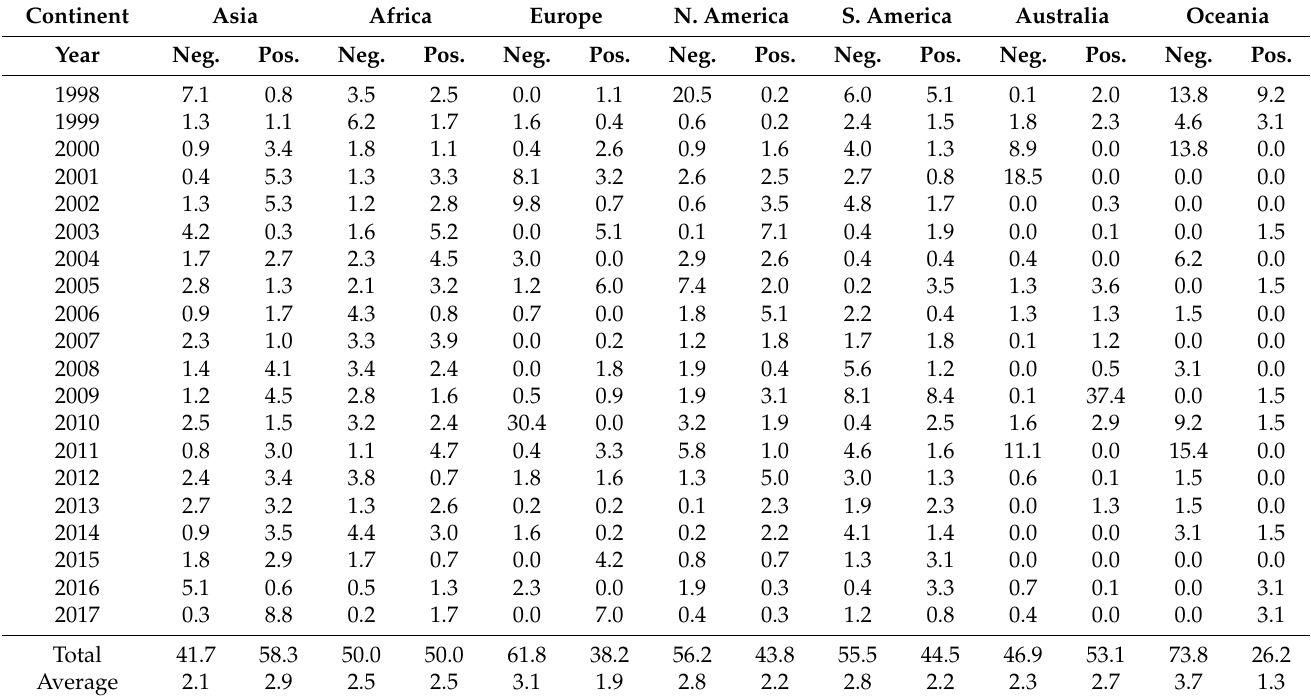
Table 2. Percentage of significant positive (Pos.) and negative (Neg.) breakpoints of precipitation on different continents. Continent Asia Africa Europe N. America